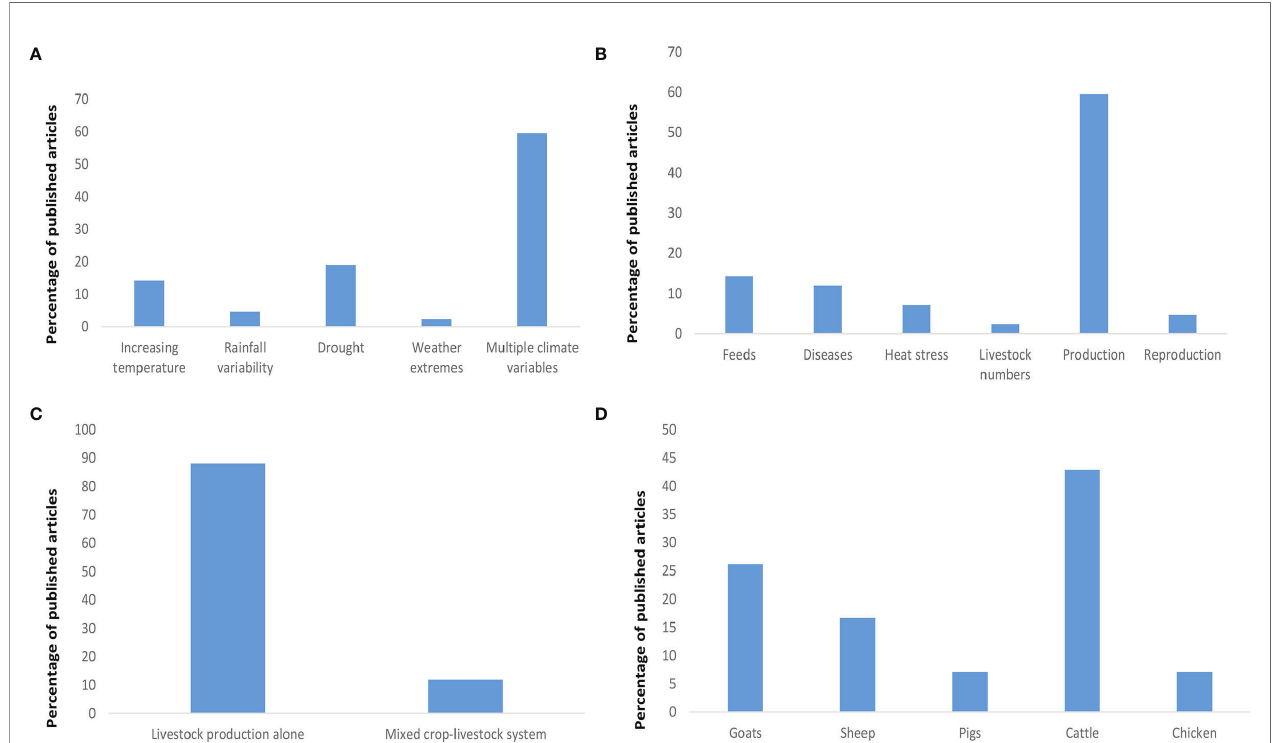
FIGURE 3 | Proportion of reviewed publications according to (A) climate change shocks, (B) domain impact, (C) livestock production system; and (D) livestock